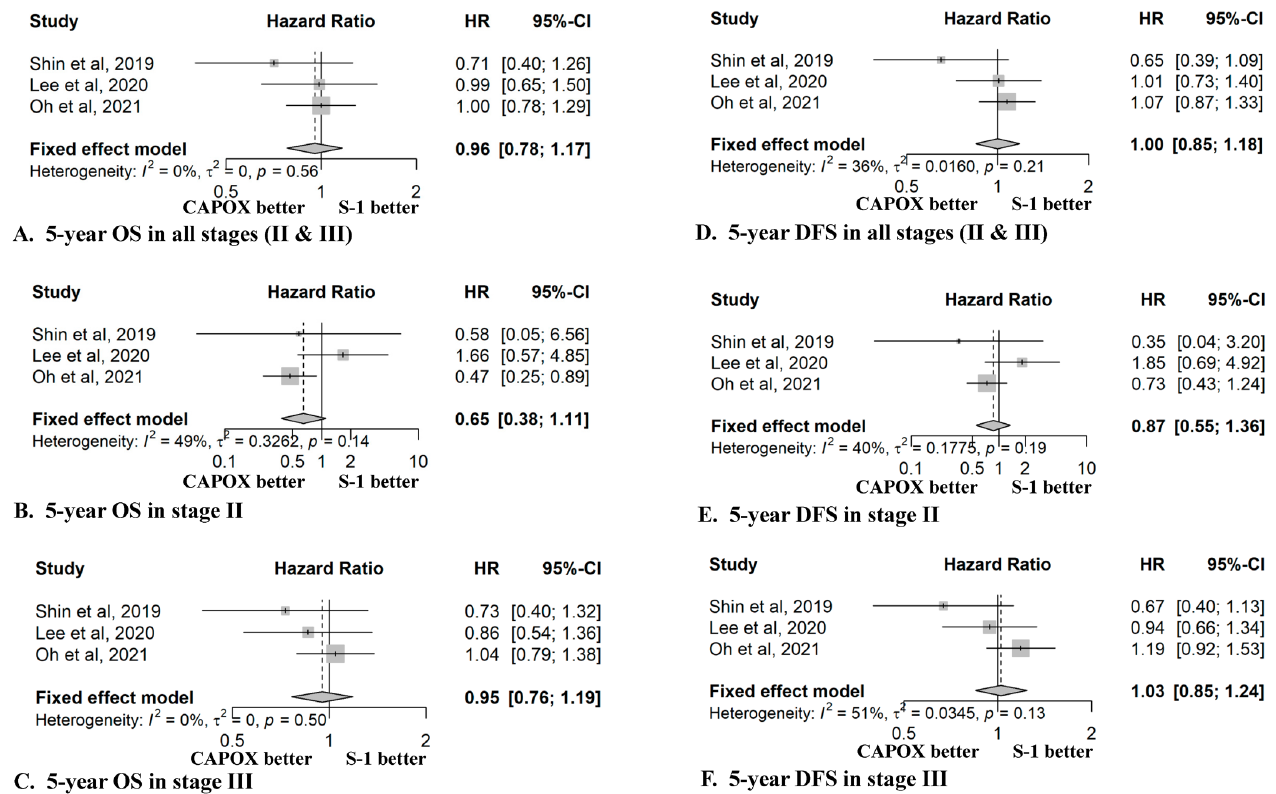
Figure 2. Comparison of the five-year overall survival and disease-free survival for S-1 and CAPOX adjuvant chemotherapy in stage II or III gastric cancer. ( A ) Five-year OS in all stages (II & III), ( B ) five-year OS in stage II, ( C ) five-year OS in stage III, ( D ) five-year DFS in all stages (II & III), ( E ) five-year DFS in stage II, ( F ) five-year DFS in stage III. ( B ) S-1,tegafur/gimeracil/oteracil; CAPOX, capecitabine plus oxaliplatin; HR, hazard ratio; CI, confidence interval; OS, overall survival; DFS, disease-free survival. Shin et al. [15]; Lee et al. [16]; Oh et al. [17]. Effect sizes were pooled using common- or random-effects models with a generic in-